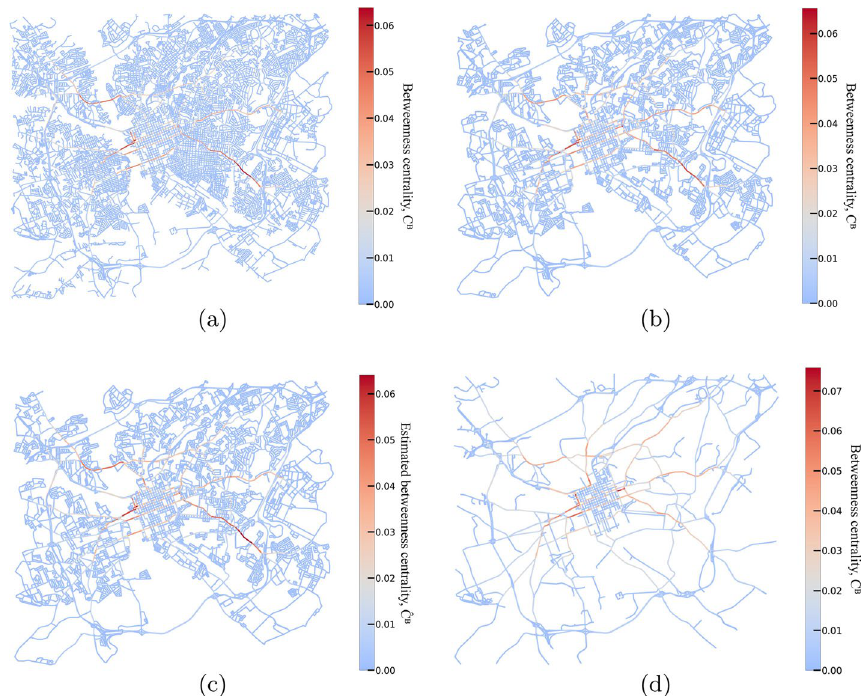
Fig. 7 C B distribution in Columbia road network: a original, b proposed method, c proposed method with centrality estimation, and d simplified by omitting all residential roads